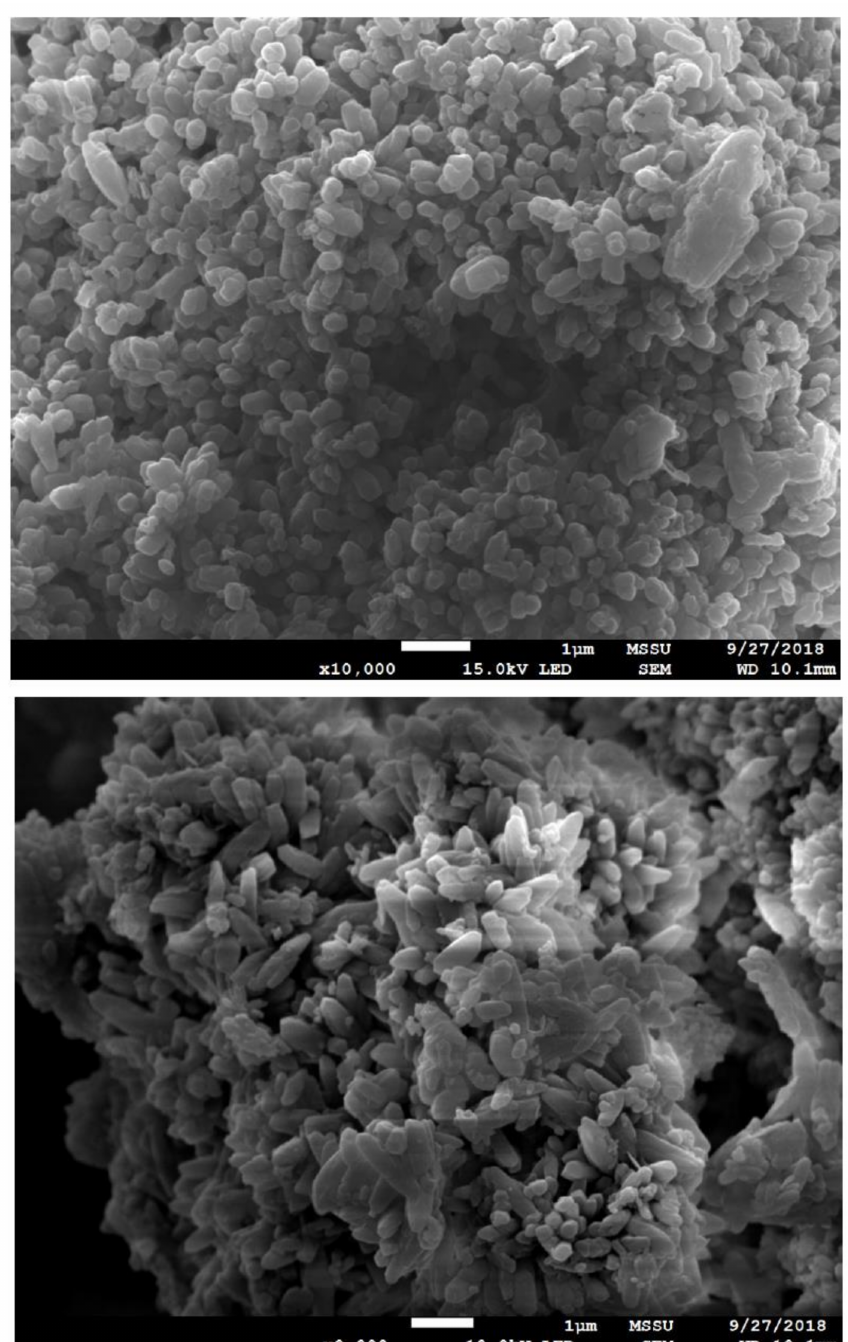
Figure 7. SEM images of the PCC obtained (time = 30 min, T = 50 ◦ C, R =